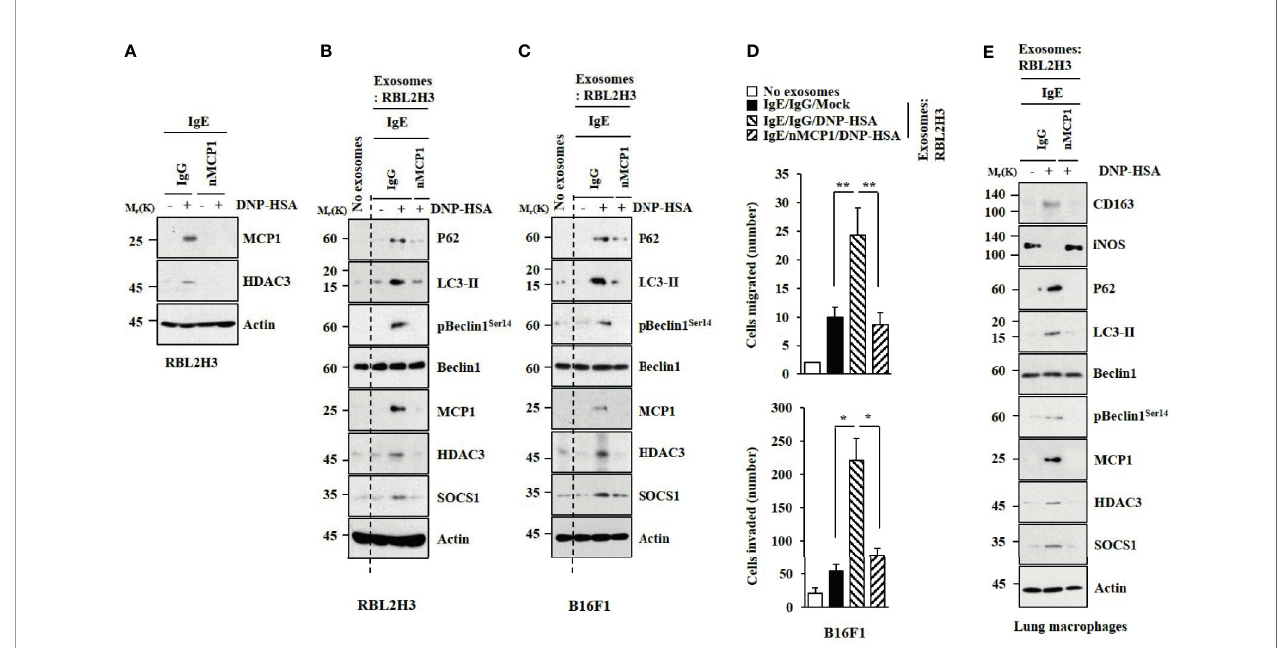
FIGURE 7 | MCP1 is necessary for effects of exosomes on cellular interactions. (A) IgE-sensitized RBL2H3 cells were preincubated with neutralizing nMCP1 antibody (2 m g/ml) or isotype-matched IgG (2 m g/ml) for 1 h followed by stimulation with DNP-HSA for 1 h. Representative blots of three independent experiments are shown. (B) Same as (A) except that exosomes were isolated from culture medium and added to unstimulated RBL2H3 cells for 24 h. Representative blots of three independent experiments are shown. (C) Exosomes were added to B16F1 cells. Representative blots of three independent experiments are shown. (D) Migration and invasion assays were performed. * p <0.05; ** p <0.01. Average values of three independent experiments are shown. (E) Same as (B) except that exosomes were added to lung macrophages. Representative blots of three independent experiments are shown.